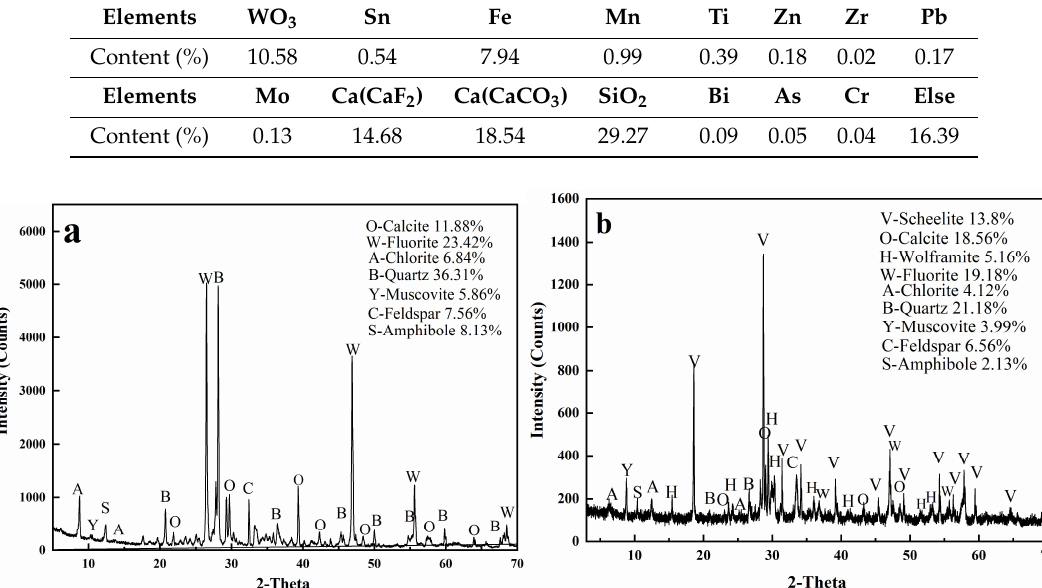
Table 4. Multi-elementary analysis results of the rougher concentrate/%.